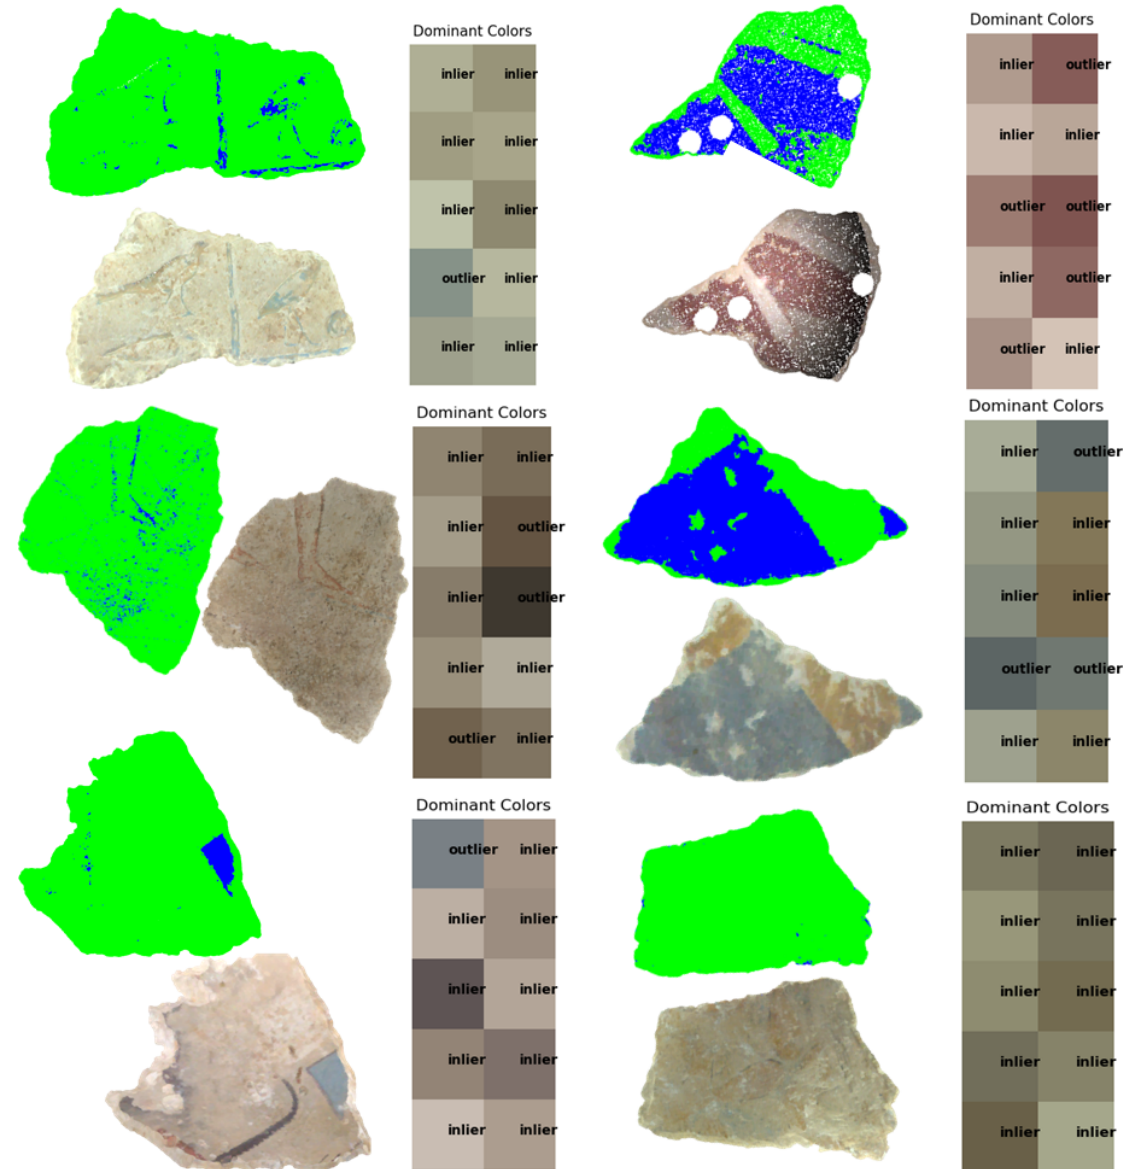
Figure 5. An example of main decorated surface extraction. The classified point-cloud depicts background colors marked in green and decoration colors marked in blue. Next to each point-cloud, the prominent colors of the surface are shown along with their label according to the classification